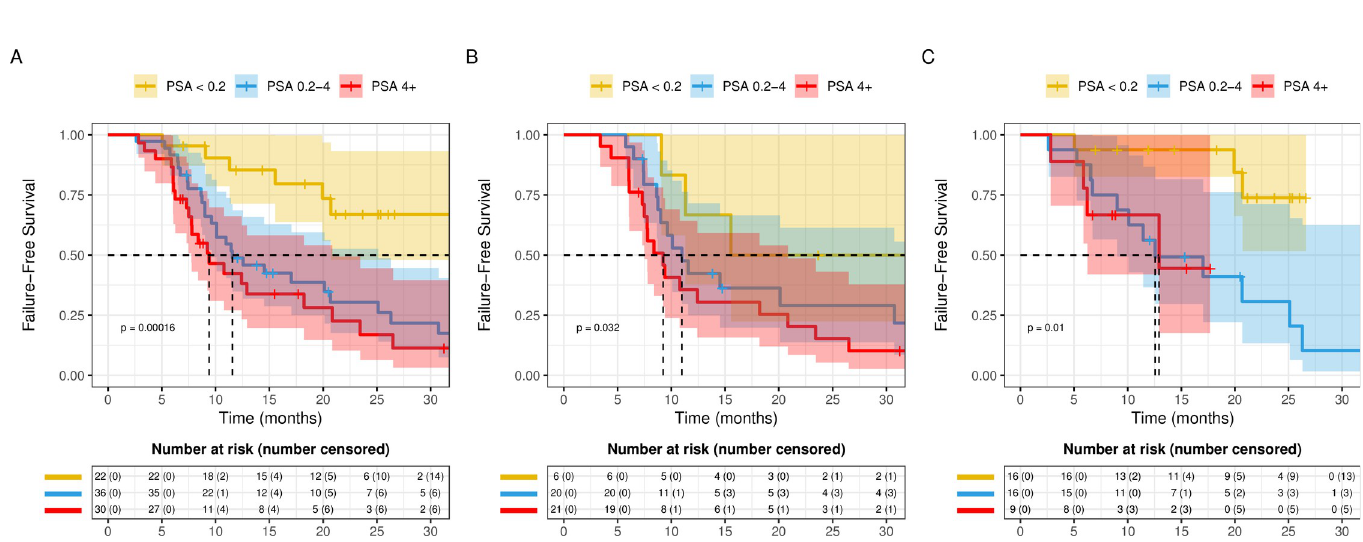
Fig 3. Kaplan-Meier analysis for time to next treatment (TTNT) comparing patients stratified by drop in PSA after treatment as mentioned in methods in A. All mHSPC patients; B. upfront Docetaxel; C. upfront NHA treated patients.